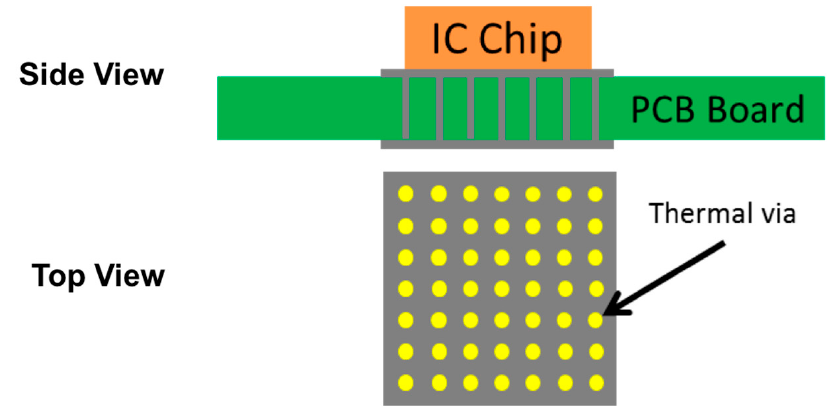
Figure 14. Positioning and layout of thermal pads and thermal vias on PCB.